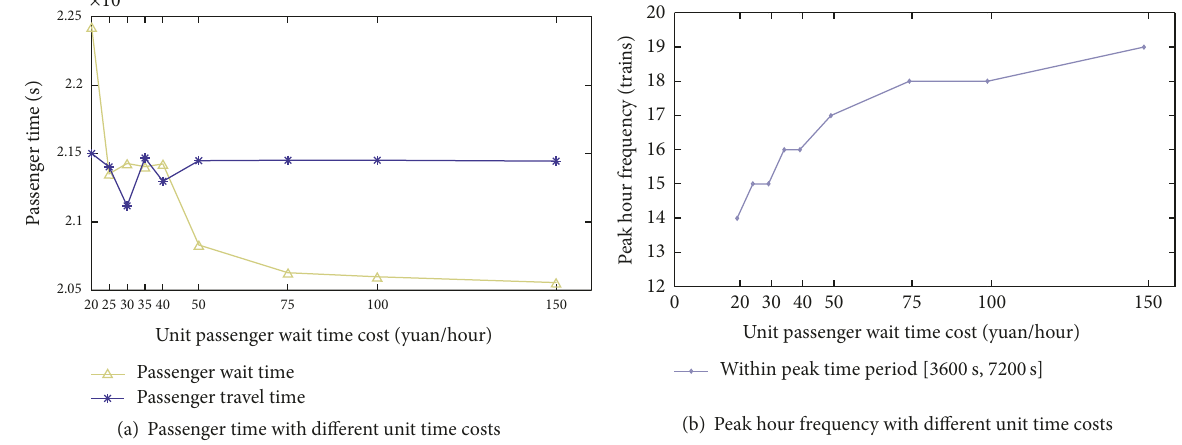
Figure 15: Sensitivity to unit passenger time cost.